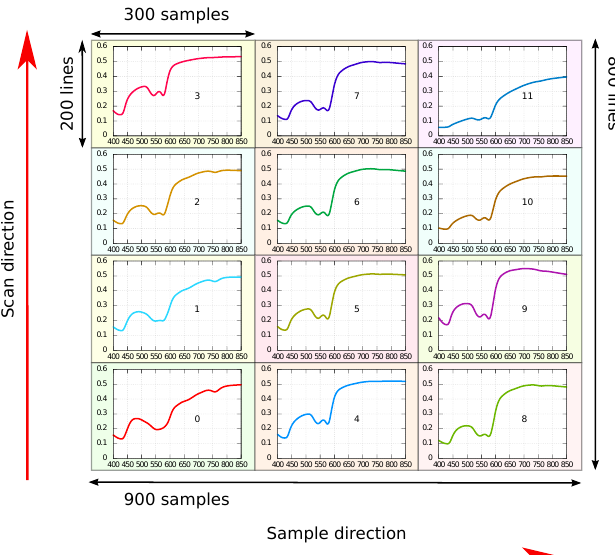
Figure 1. Simulated hyperspectral image. Each region of the image corresponds to a predefined set of optical properties (shown as a plot of the diffuse reflectance within each